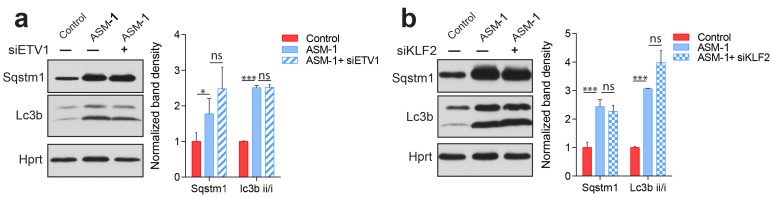
Autophagy defects in Niemann Pick patients are independent of Klf2 and Etv1.To assess if silencing of ETV1 or KLF2 in ASM-deficient fibroblasts had any impact on lysosomal function, we assessed the accumulation of autophagic substrates p62 (Sqstm1) and LC3BII, a marker of autophagosomes. No effect on these parameters was observed when ETV1 (panel a) or KLF2 (panel b) was silenced, as assessed by western blot. Quantification shows the mean ± s.e.m, n = 3. T-test p-value *p<0.01 ***p<0.001; non-significant (ns) p>0.05.